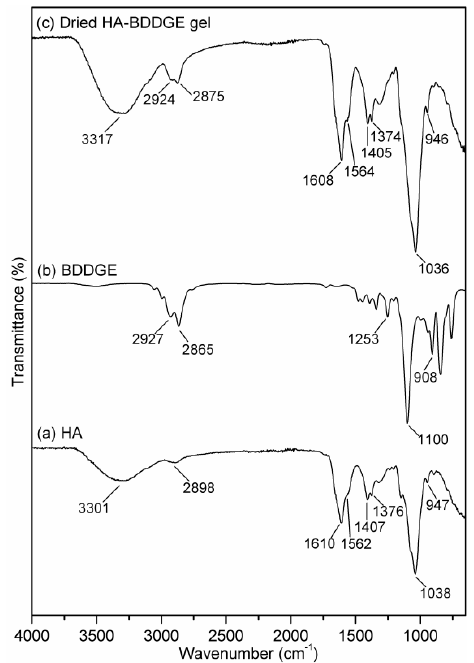
Figure 1. ATR-Fourier transform infrared spectroscopy (FTIR) spectra of ( a ) HA, ( b ) BDDGE, and ( c ) dried sodium hyaluronate-BDDGE patterned gel (HA-BDDGE) gel. dried sodium hyaluronate-BDDGE patterned gel (HA-BDDGE)